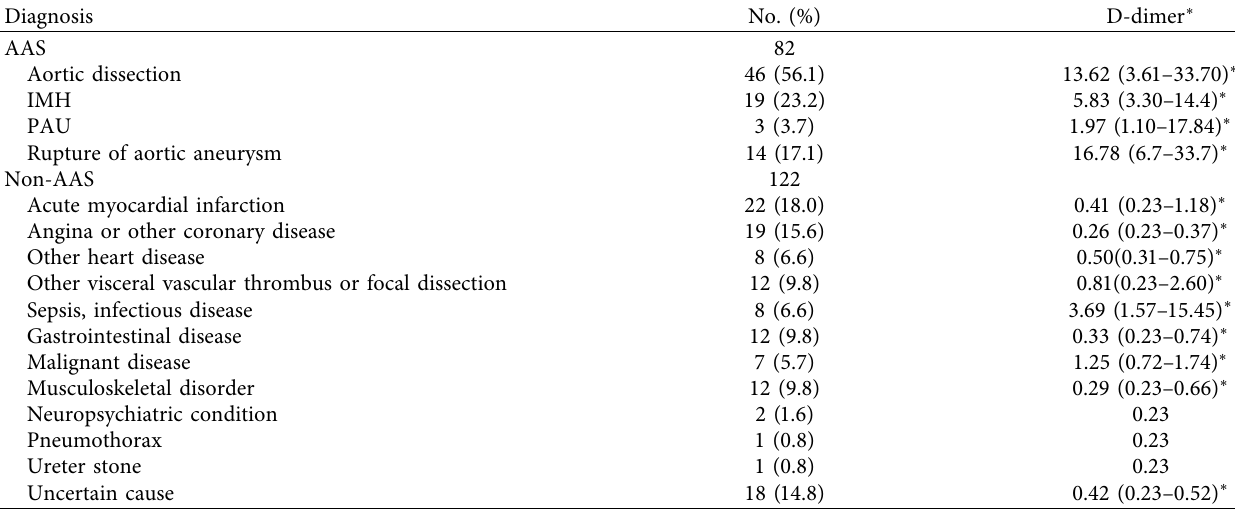
Table 5: D-dimer ( μ g/mL) levels in diagnosis categories.